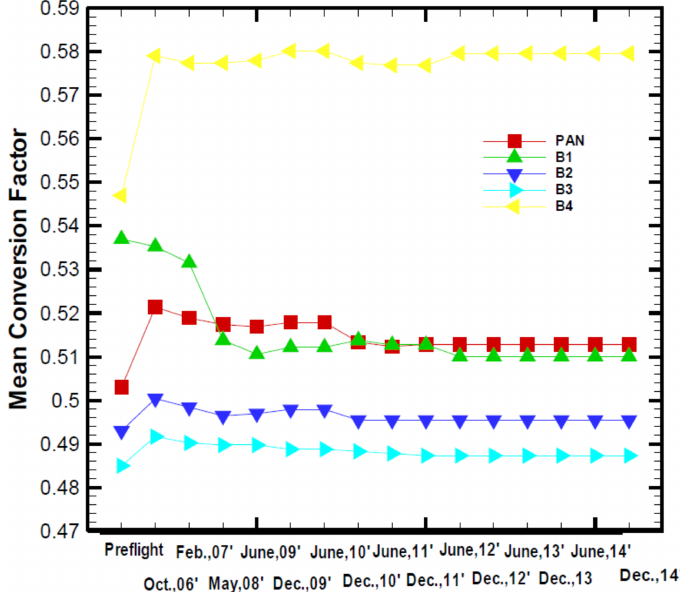
Figure 1. Temporal variation of mean conversion factor of all bands for FORMOSAT-2 remote-sensing instrument (FS-2 RSI) caused by sensors’ degradation. B1: Band 1 (green); B2: Band 2 (blue); B3: Band 3 (cyan); B4: Band 4 (yellow); PAN (red, panchromatic band)